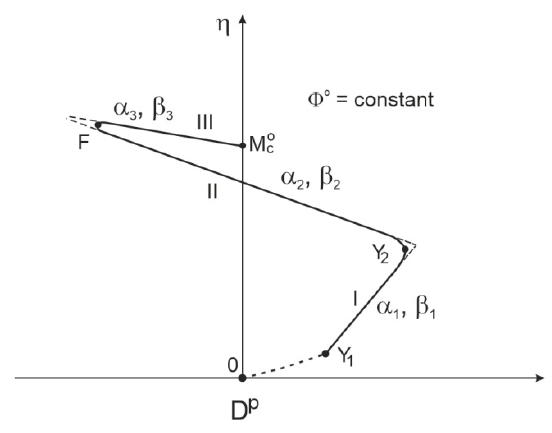
Figure 4. Characteristic relationship between the stress ratio and plastic dilatancy.